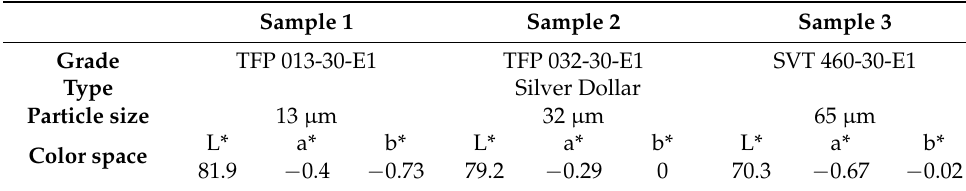
Table 4. Color space comparison for aluminum flakes of different sizes.